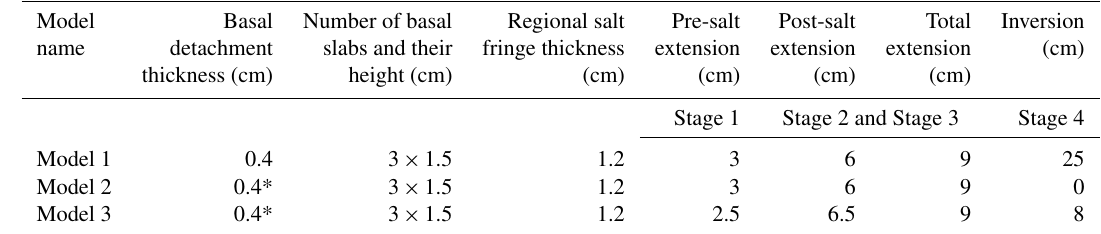
Table 1. Model names and values for extension and inversion for experiments described in the main text. Model Basal name detachment slabs and their